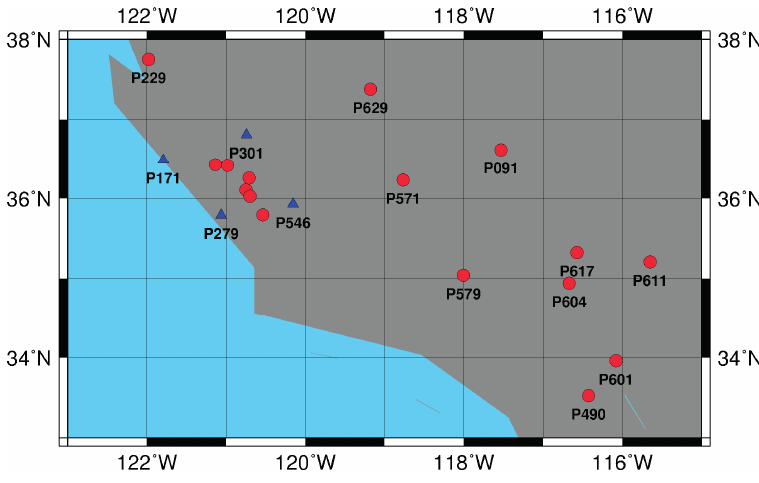
Figure 5. Network distribution in the experiment.